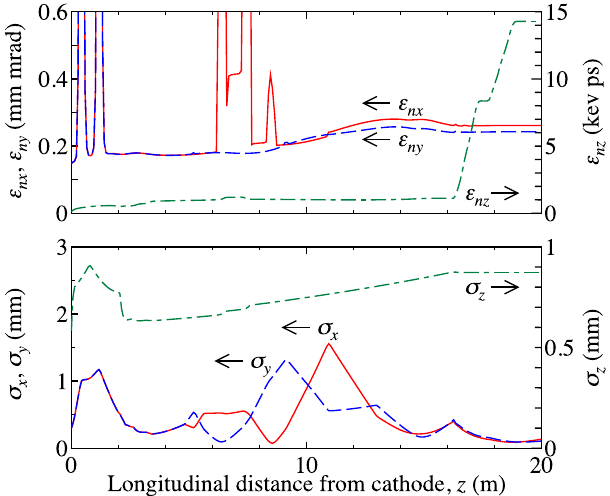
FIG. 4. Beam evolution in the injector optimized for 0.77 pC bunch charge: normalized rms emittances (top), transverse beam sizes and bunch length (bottom) versus position in the injector.